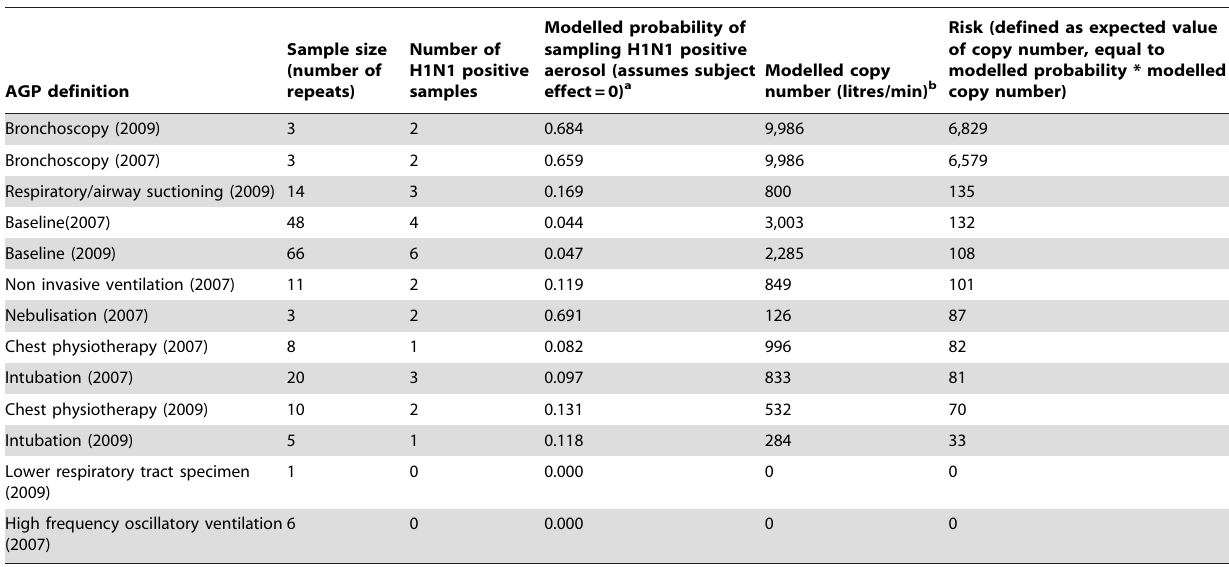
Table 10. Risk summary stratification